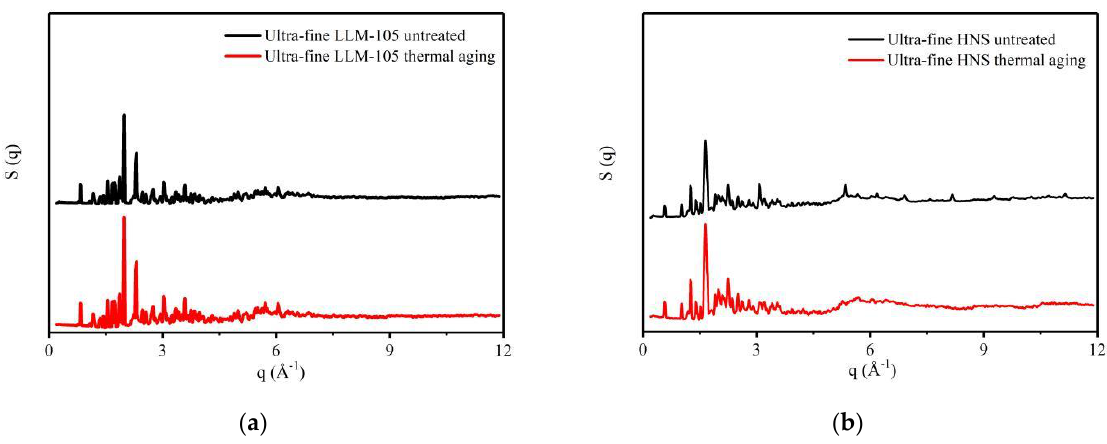
Figure 6. Structure factors of explosives before and after thermal aging: ( a ) LLM-105; ( b ) HNS. The variation range of each peak in the PDF curve is small, and the overall trend of PDF curve is similar after heat aging treatment of ultra-fine LLM-105 and HNS. The peak positions of ultra-fine LLM-105 after heating aging shift to the right within 1–2.7 Å. For example, the peak position at 1.15 Å moves to 1.27 Å and the peak width decreases from 0.46 to 0.44, which indicates that the average covalent bond distance in the molecule increases, the interaction force becomes weak, and the disorder degree decreases. For HNS, the results are opposite to LLM-105. Compared with the HNS before aging, the peak areas of ultra-fine HNS after thermal aging within 1–3 Å generally increased. For example,